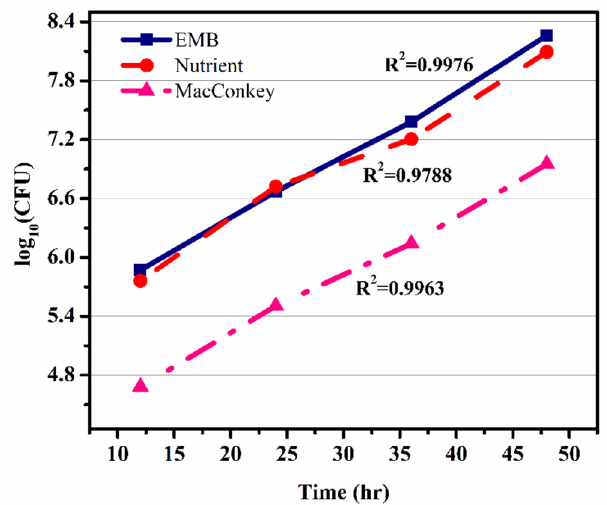
Figure 6. Dependence of log 10 (CFU) on time in eosin methylene blue agar, nutrient agar, and MacConkey agar.